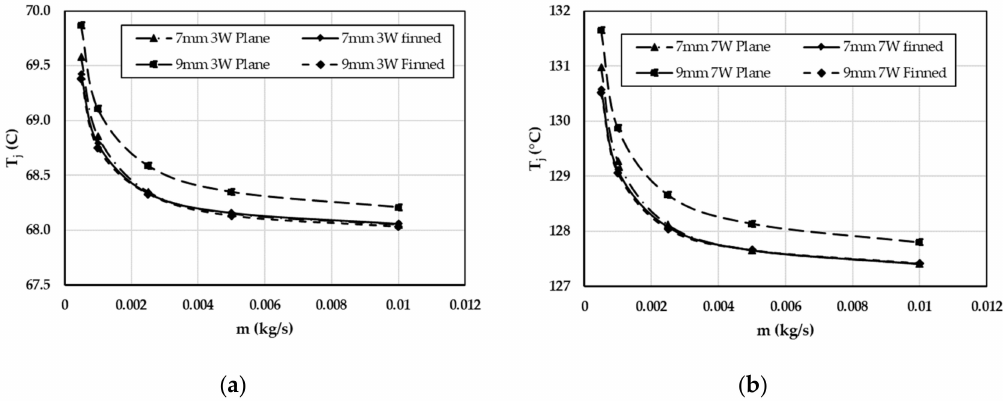
Figure 11. The variation of the junction temperature with mass flow rate for: ( a ) 3 W LED power; ( b ) 7 W LED